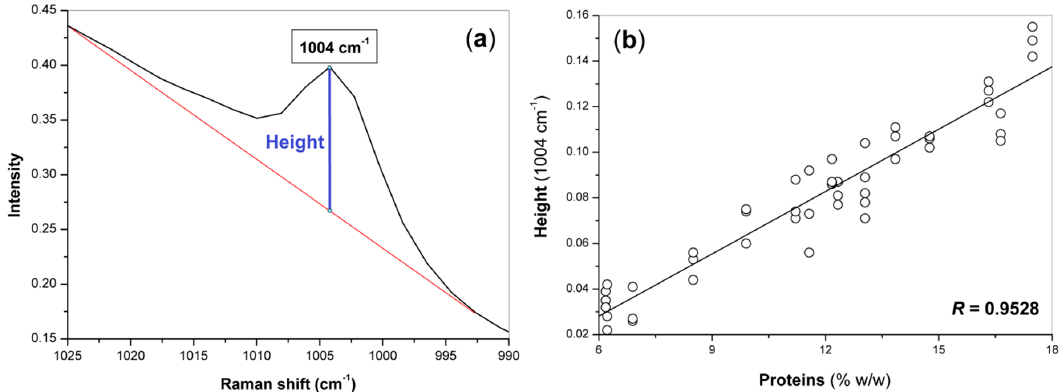
Figure 5. Using the Raman band of the Phe ring breathing vibration at 1004 cm − 1 for determination of proteins in P. ostreatus basidiocarps: ( a ) measuring of the height; ( b ) correlation between this height and protein content (% w / w ).